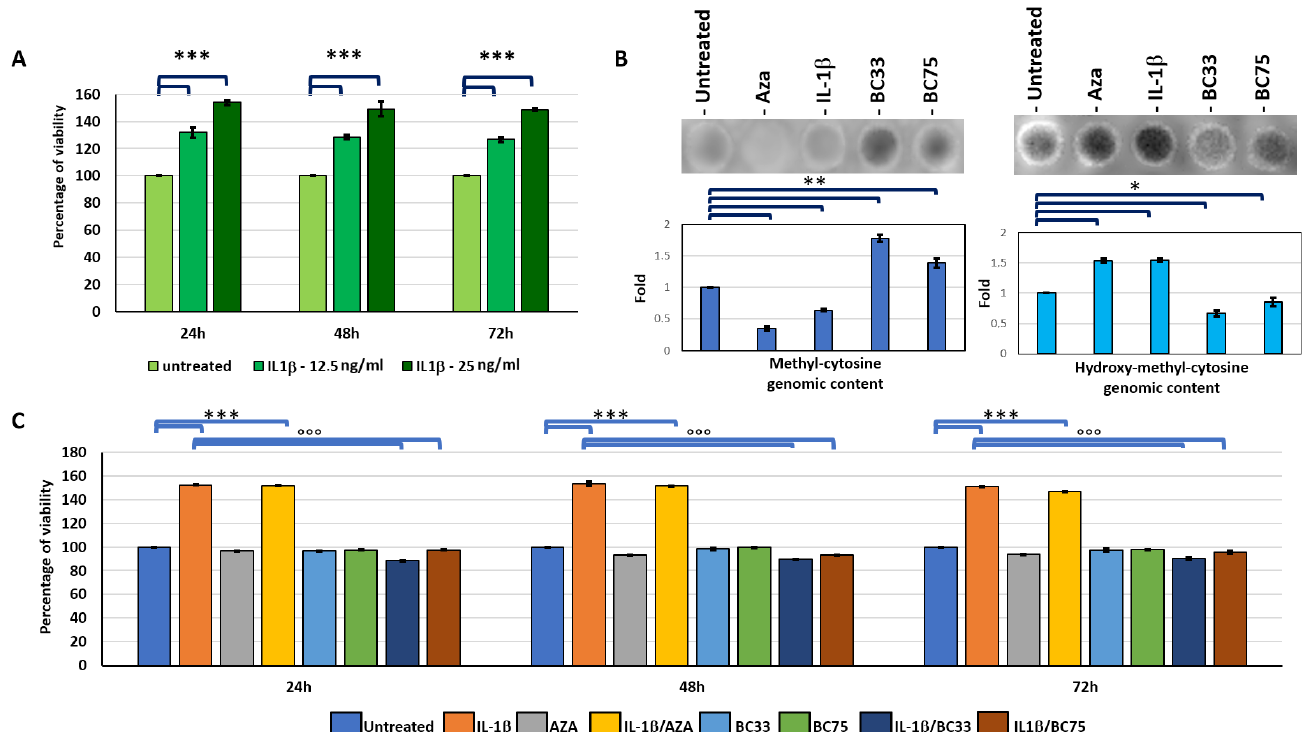
Figure 1. ( A ) Percentage of viability of MCF-7 (MTT assay) treated with 2 different concentrations of IL-1 β (12.5 and 25 ng/mL) at 24, 48, and 72 h (Mean ± SD, n = 4). Two-way ANOVA showed a significant interaction ( p < 0.0005) of treatment and experimental time factors on MCF-7 viability results. Significant differences among tested treatments at each experimental time ( * ) are reported in the graphs (1 symbol, p < 0.05; 2 symbols, p < 0.005; 3 symbols, p < 0.0005). ( B ) Representative images and diagram of densitometric analysis of spot hybridization of DNA from cell MCF-7 untreated or treated with AZA (10 µM), IL-1 β (25 ng/mL), BC33 (Bobcat339, 33 µM), and BC75 (Bobcat339, 75 µM) using antibody through methyl-cytosine and hydroxy-methyl-cytosine (Mean ± SD, n = 3). One-way ANOVA showed the significant effect of treatment on densitometric data ( p < 0.0005); significant differences among tested treatments vs. untreated MCF-7 are reported in the graphs (1 symbol, p < 0.05; 2 symbols, p < 0.005; 3 symbols, p < 0.0005). ( C ) Percentage of viability of MCF-7 treated with IL-1 β , AZA, BC33, BC75, and co-treatment IL-1 β /AZA and IL-1 β /BC33 or BC75 (Mean ± SD, n = 4). Two-way ANOVA showed a significant interaction ( p < 0.0005) of treatment and experimental time factors on MCF-7 viability results. Significant differences among tested treatments vs. untreated MCF-7 (*), and vs. IL-1 β MCF-7 (°) are reported in the graphs ((*, p < 0.05; ** p < 0.005; *** and °°°, p < 0.0005).